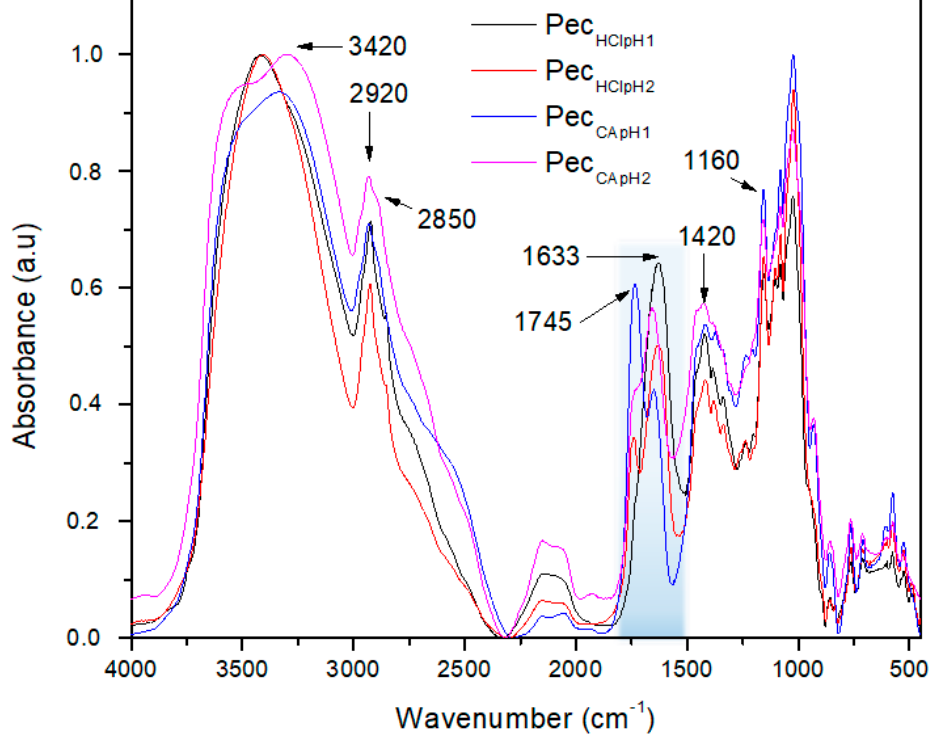
Figure 1. FT-IR spectra of pectin samples: ---- Pec HClpH1 , ---- Pec HClpH2 , ---- Pec CApH1 , ---- Pec CApH2.